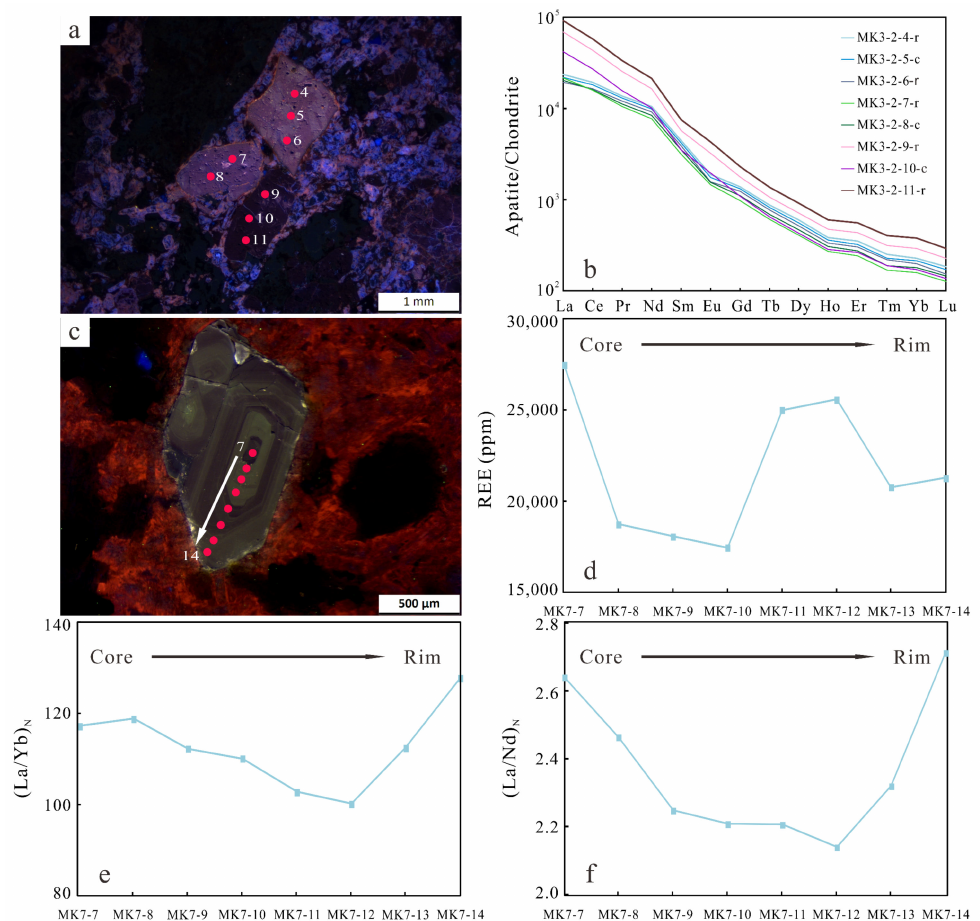
Figure 10. Apatite from magnetite-apatite-enriched rocks and syenites displaying trace-element variations. ( a , b ) Dark purple luminescent apatite grains characterized by higher REE contents than the light purple luminescent ones; ( c – f ) trace element composition variation trends recording the oscillatory zonation of apatite within syenite. The red dots and the accompanying number ( a , c ) refer to the analytical points of samples. 4–11 in ( a ) refer to MK3-2-4 to MK3-2-11 in ( b ); 7, 14 in ( c ) refer to MK7-7 and MK7-14 in ( d – f